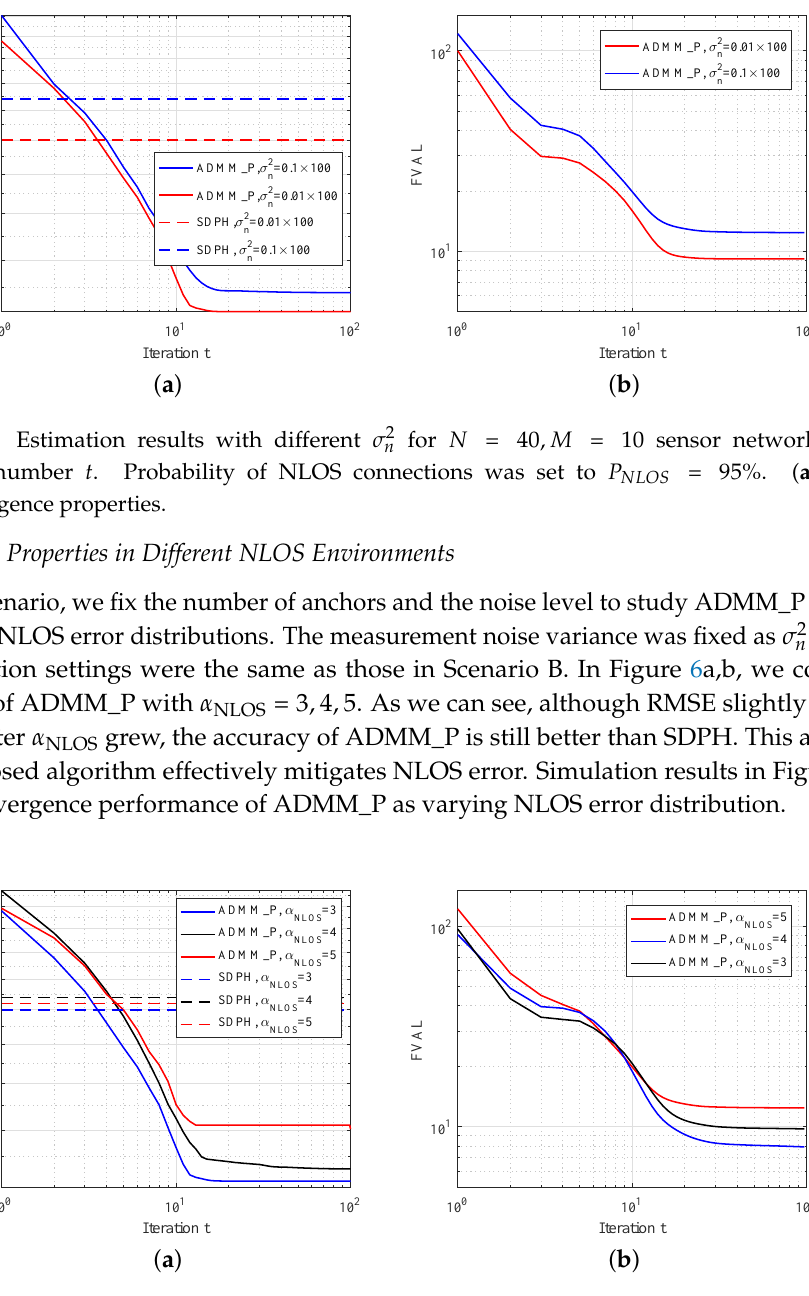
Figure 6. Estimation results with different α NLOS for N = 40, M = 10 sensor network versus iteration number t . Probability of NLOS connections was set to P NLOS = 95%. ( a ) RMSE; ( b ) convergence